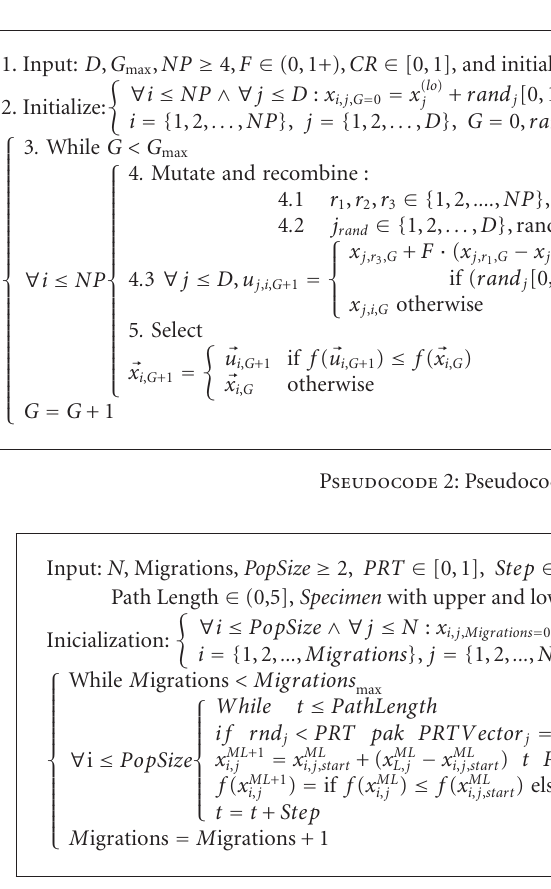
Pseudocode 3: Pseudocode of SOMA.